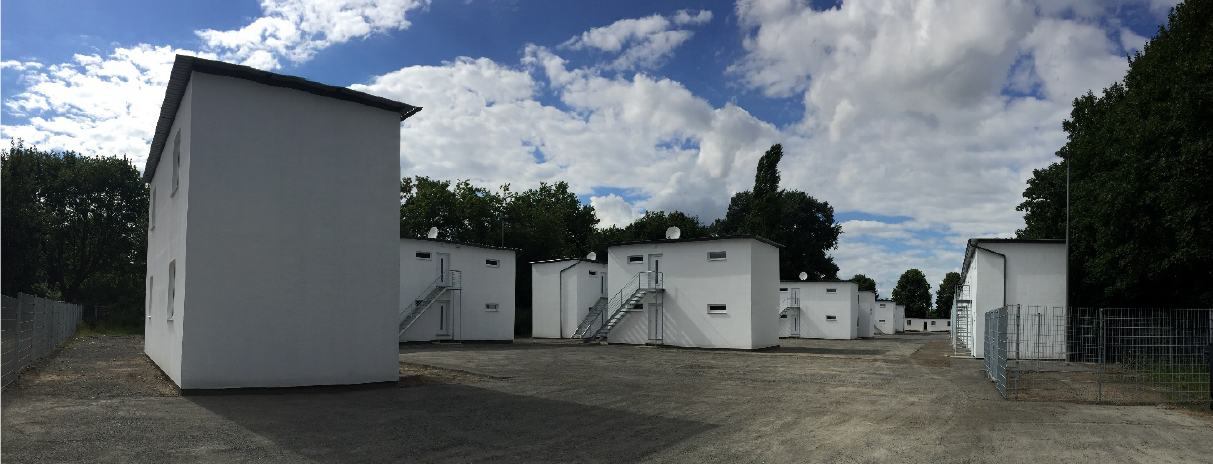
Figure 8. A purpose-built refugee accommodation compound for 200 people. The wooden-made structures resemble the design of modular container-villages and consist of two-floor structures with 2–4-person apartments. Source: author.